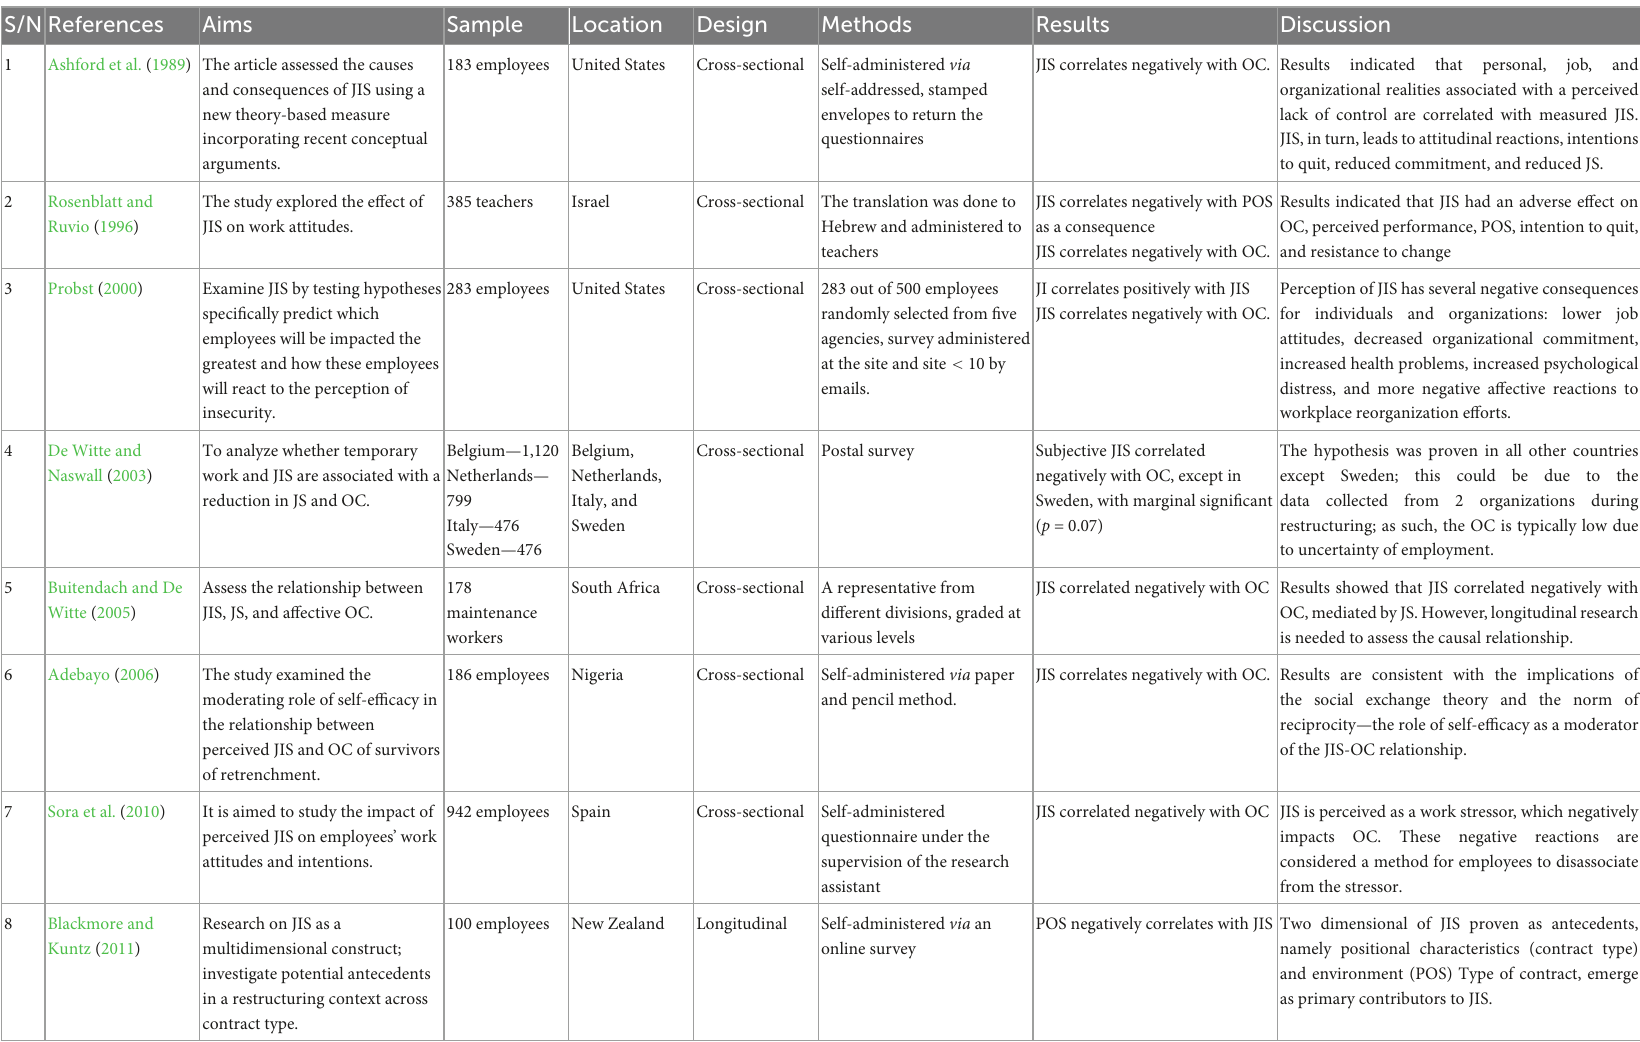
TABLE 1 Summary of the articles